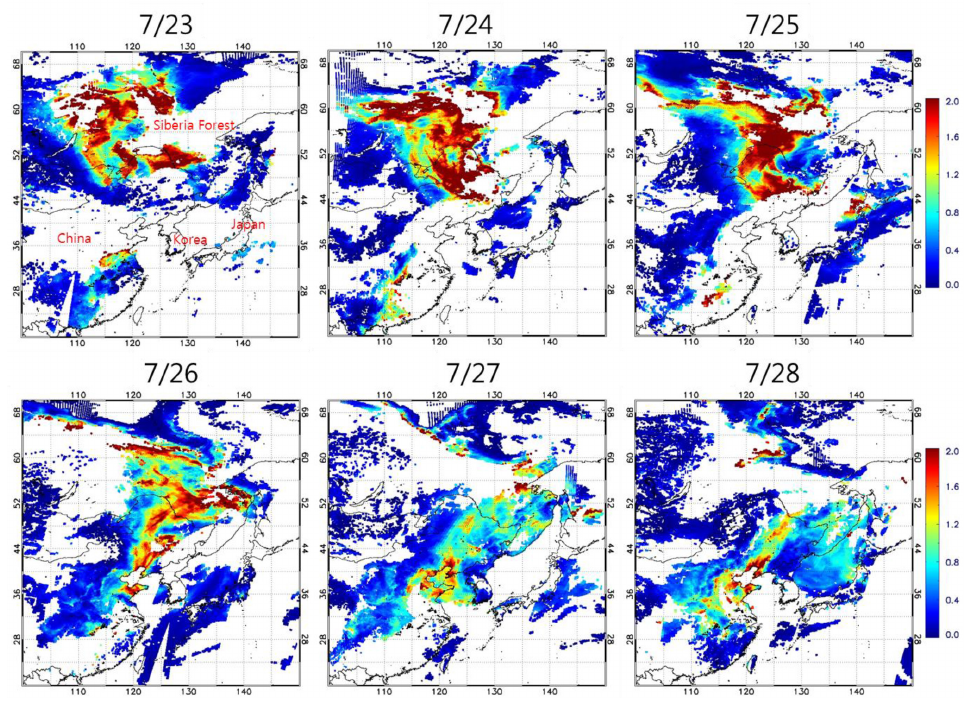
Figure 4. MODIS AOD over East Asia from 23 to 28 July 2014.